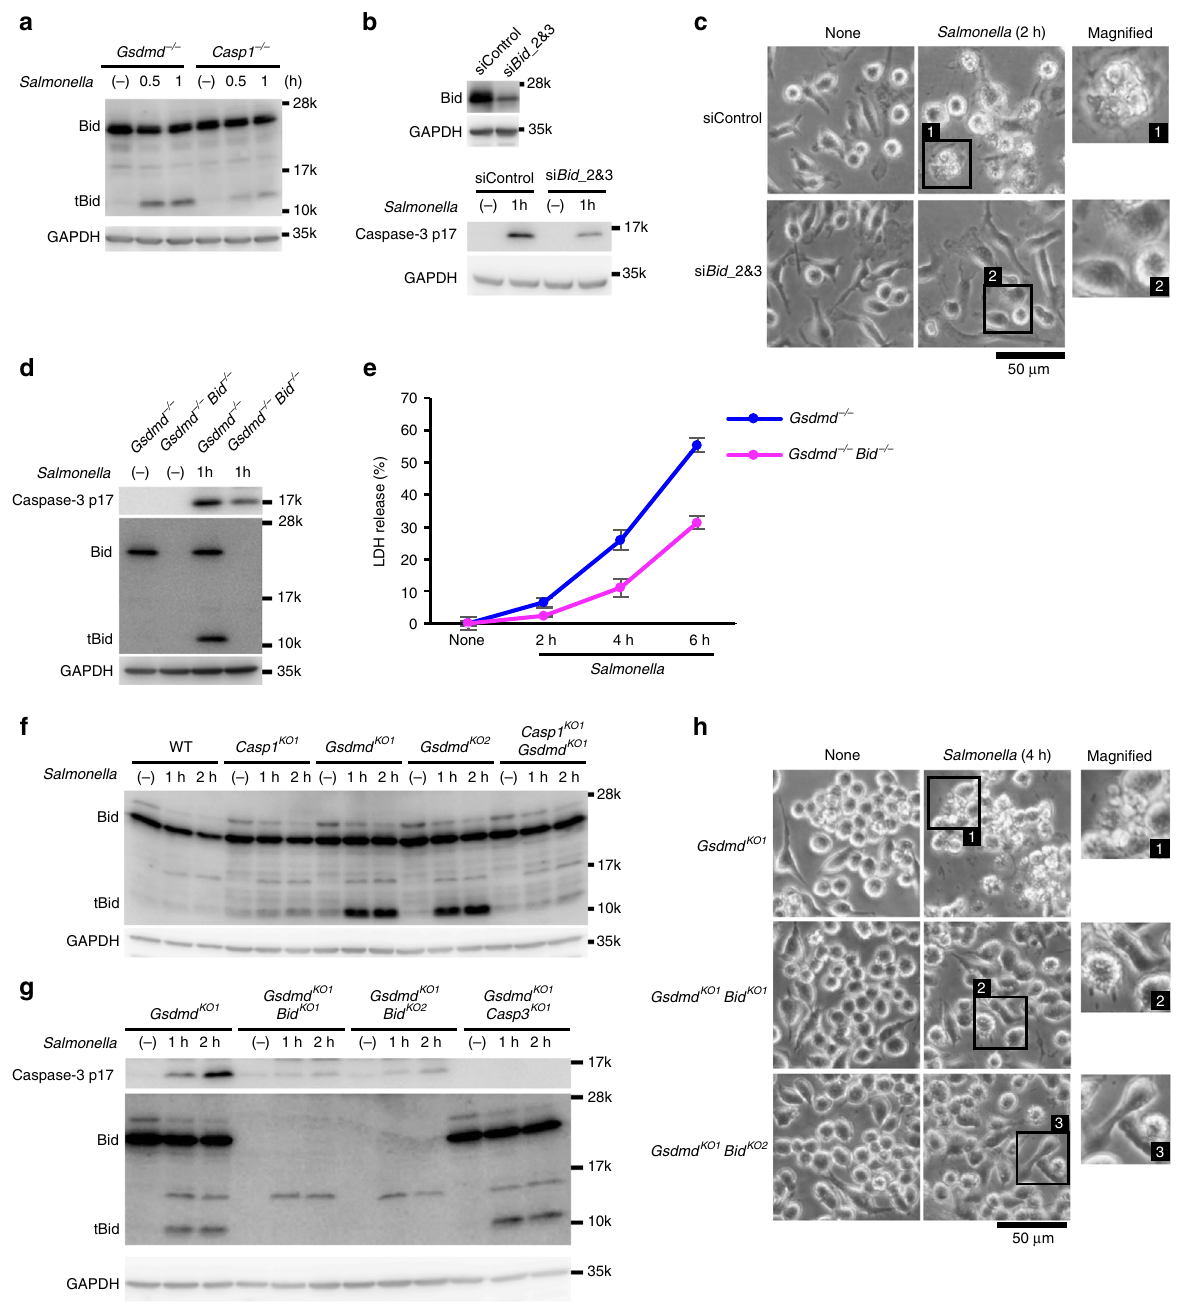
Fig. 7 Bid is involved in caspase-1-induced apoptosis in macrophages. a BMMs from Gsdmd − / − and Casp1 − / − mice were infected with S . Typhimurium as in Fig. 1d. Bid in cell lysates was detected by Western blotting. b – e Gsdmd − / − BMMs were transfected with control siRNA or Bid siRNAs ( b , c ). Two days after transfection, the cells were again transfected with the same siRNAs and incubated for an additional 2 days ( b , c ). BMMs were prepared from Gsdmd − / − and Gsdmd − / − Bid − / − mice ( d , e ). The cells were then infected with S . Typhimurium as in Fig. 1d ( b , d ), Fig. 1c ( c ) or Fig. 1 b ( e ). Bid and cleaved caspase-3 in cell lysates were detected by western blotting ( b , d ). Microscopic images ( c ). LDH release ( e ). f – h RAW264.7 cells of the indicated genotypes were infected with S . Typhimurium as in Fig. 1f ( f , g ) or Fig. 1e ( h ). Western blot detection of cleaved caspase-3 and Bid in cell lysates ( f , g ). Microscopic images ( h ). In e , the graph depicts the mean ± SD of triplicate cultures. Data are from one representative of three biologically independent experiments ( a – e ) and three independent experiments ( f – h ) with similar results. Source data are provided as a Source Data fi le. (See also Supplementary Figs. 10 and